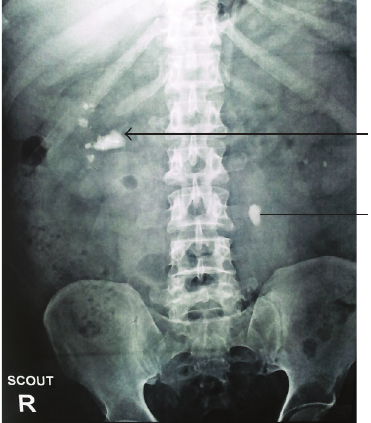
Figure 1: Plain X-ray KUB showing right renal pelvic calculus with the stainless steel embolization coil within it and multiple calyceal stones(arrow).Leftupperuretericstonewasalsoseen(straightline).